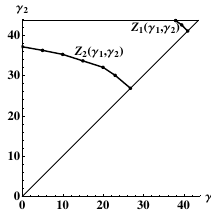
Figure 2. Z 1 (1), Z 2 (1) for BVP x (cid:48)(cid:48) = x 3 − (5 π/ 2) 2 x , x (0) = x (1) = 0, u (cid:48) (0) = 0 , v (cid:48) (0) = 43 . 594 (schematically).